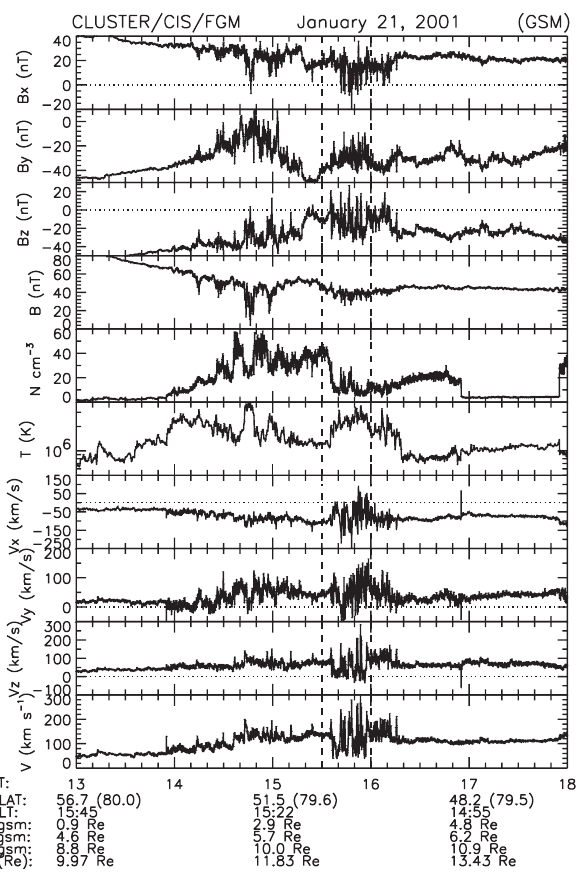
Fig. 10. Data from the Cluster traversal through the cusp. Top to bottom: Magnetic field components and magnitude; ion density, temperature, velocity components, and magnitude. The interval be- tween vertical dashed lines is expanded in Fig. 10.